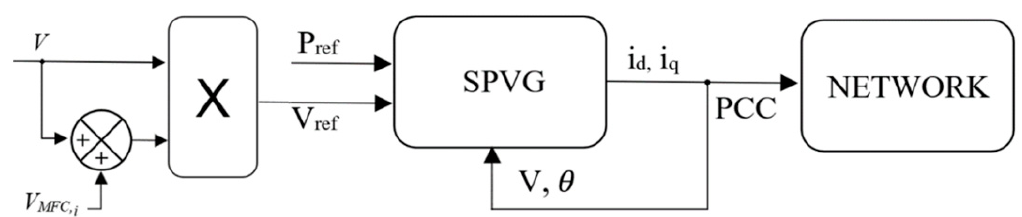
Figure 12. PE-based DER model—solar photovoltaic generator (SPVG)—constant P-V mode. Energies 2020 , 13 , x FOR PEER REVIEW